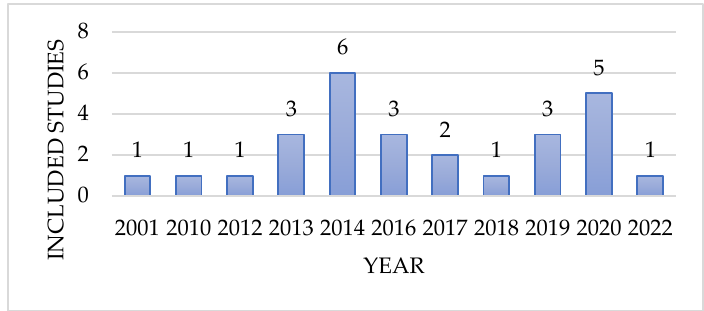
Figure 2. The year range of included studies.